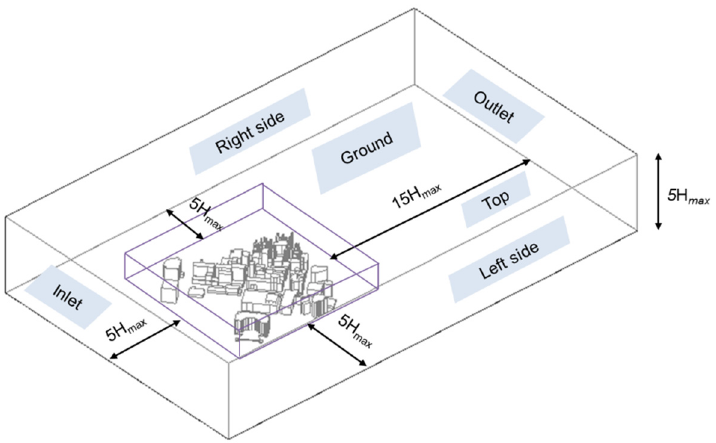
Figure 5. Dimensions of the computational domain.